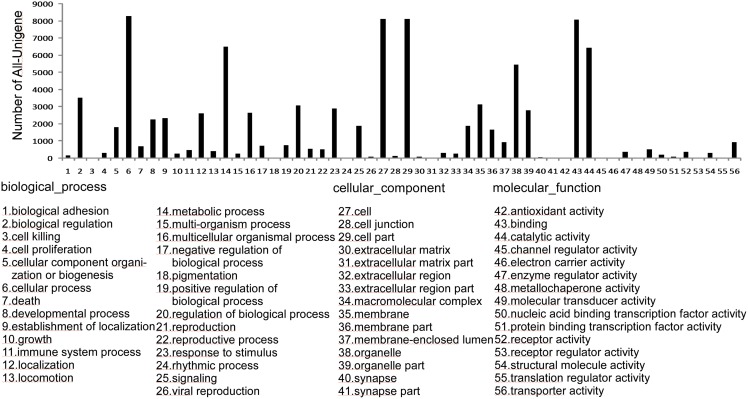
Gene ontology of genes annotated with GO terms.